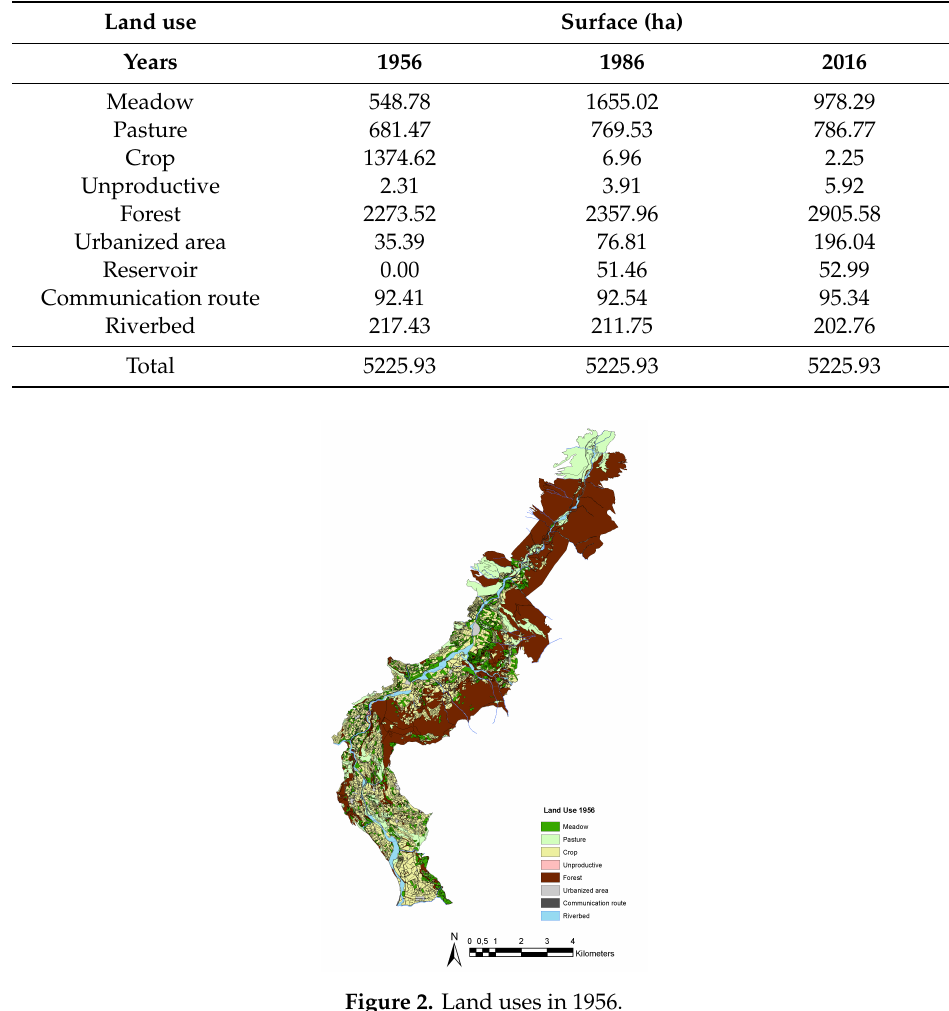
Table 1. Area of land uses in the years 1956, 1986, and 2016 of the mapped area.